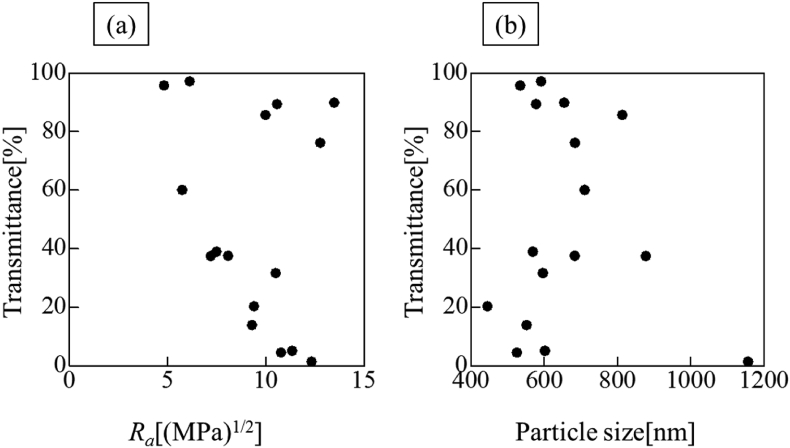
Relationship between transmittance and Ra or particle diameter when light wavelength is 500 nm. (a) Transmittance vs. Ra, (b) Transmittance vs. particle size.